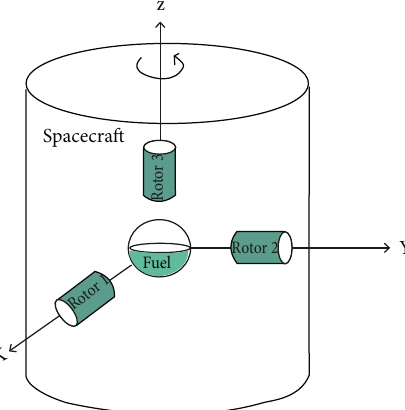
Figure 1: Spacecraft attached with partially filled fuel tank and three rotors. This figure is reproduced from the work of Sabir et al. [7] with the assumption that the third rotor is rotating about z